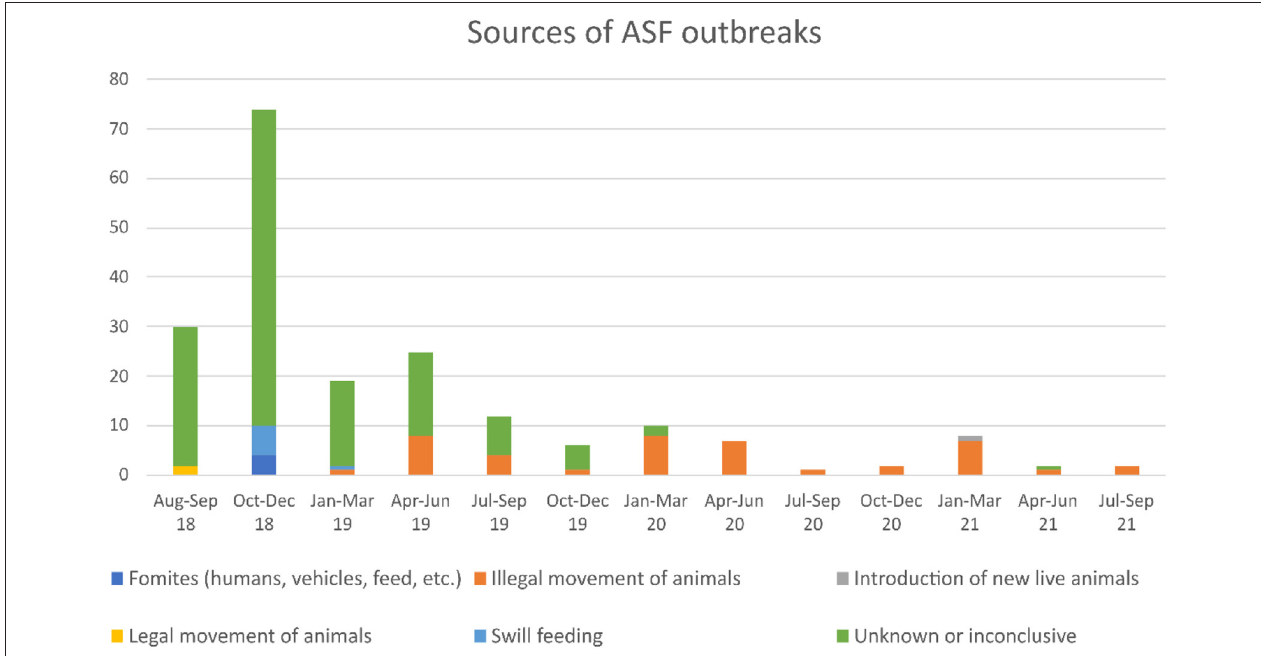
FIGURE 1 | Temporal trend of African swine fever (ASF) in China. The number of ASF outbreaks every 3 months, including the details of the event sources, is shown in a bar graph. These information sources are based on official reports to the OIE.